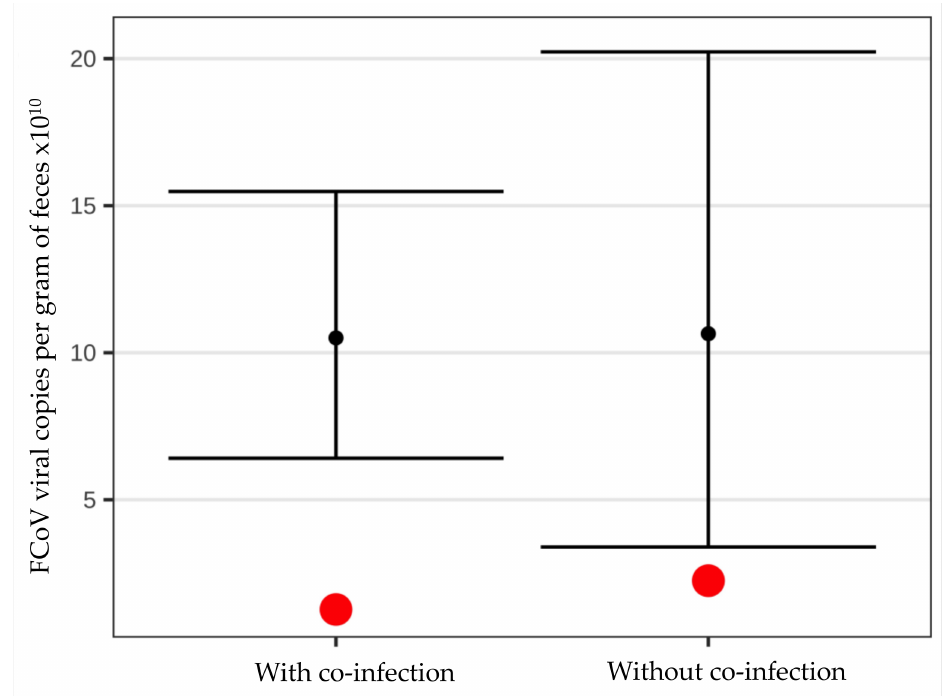
Figure 5. Bootstraps demonstrating the difference in fecal feline coronavirus (FCoV) load in viral copies per gram (g) of feces between FCoV-infected cats with and without co-infection with other potential enteropathogens. Black points represent the mean fecal FCoV load in viral copies per g of feces. Red points represent the median fecal FCoV load in viral copies per g of